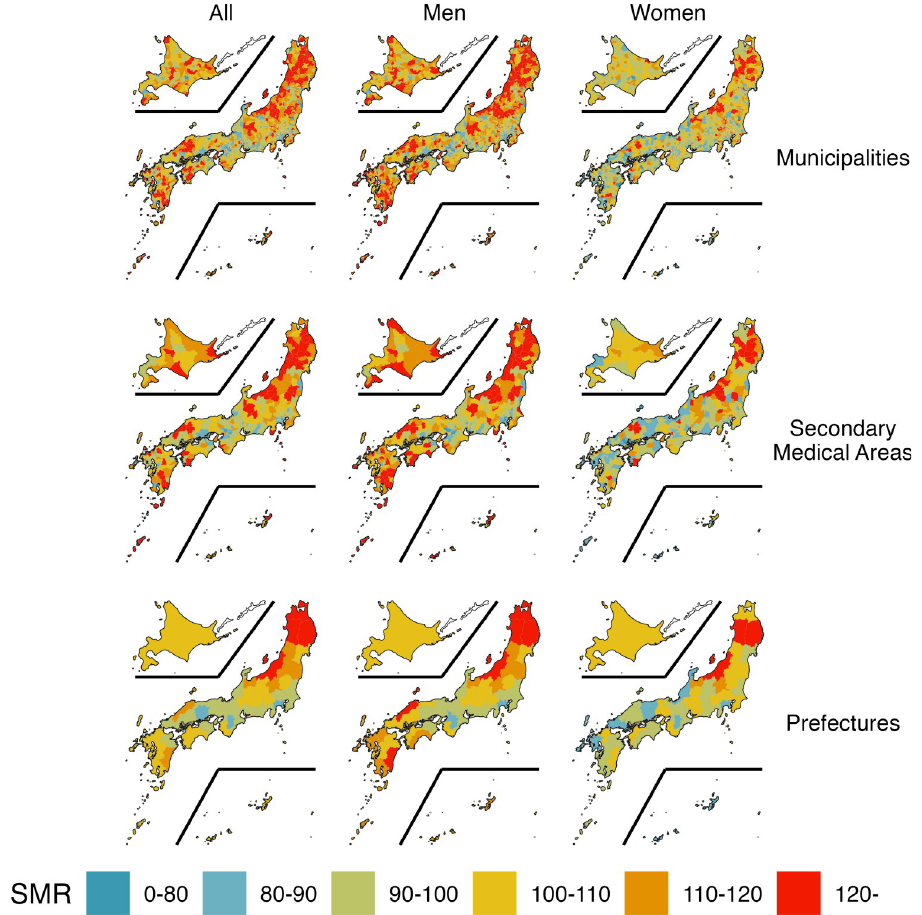
Fig 2. Geographical distribution of standardized death ratios for suicides. The standardized mortality ratios (SMRs) for all ages in 1887 municipalities, 334 secondary medical areas, and 47 prefectures in Japan during 2009–2018 were calculated and plotted. The plots were divided into facets by region size on the vertical axis and gender on the horizontal axis. The following map data (CC BY 4.0) was processed and used: Ministry of Land, Infrastructure, Transport and Tourism. National surveys of Japan—Administrative area data (in Japanese). 2019. Available from: https://nlftp.mlit.go.jp/ksj/gml/datalist/KsjTmplt-N03-v3_0.html.